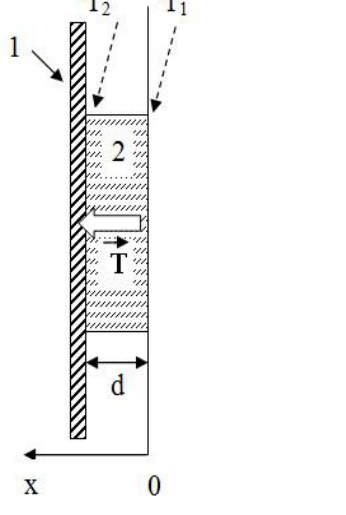
Table 2. Value of temperature gradient in films containing filler ZnO (Δ T 1 ) and in films without filler (Δ T 2 ), as well as the numerical ratio of the thermal conductivity coefficient ( T , о С